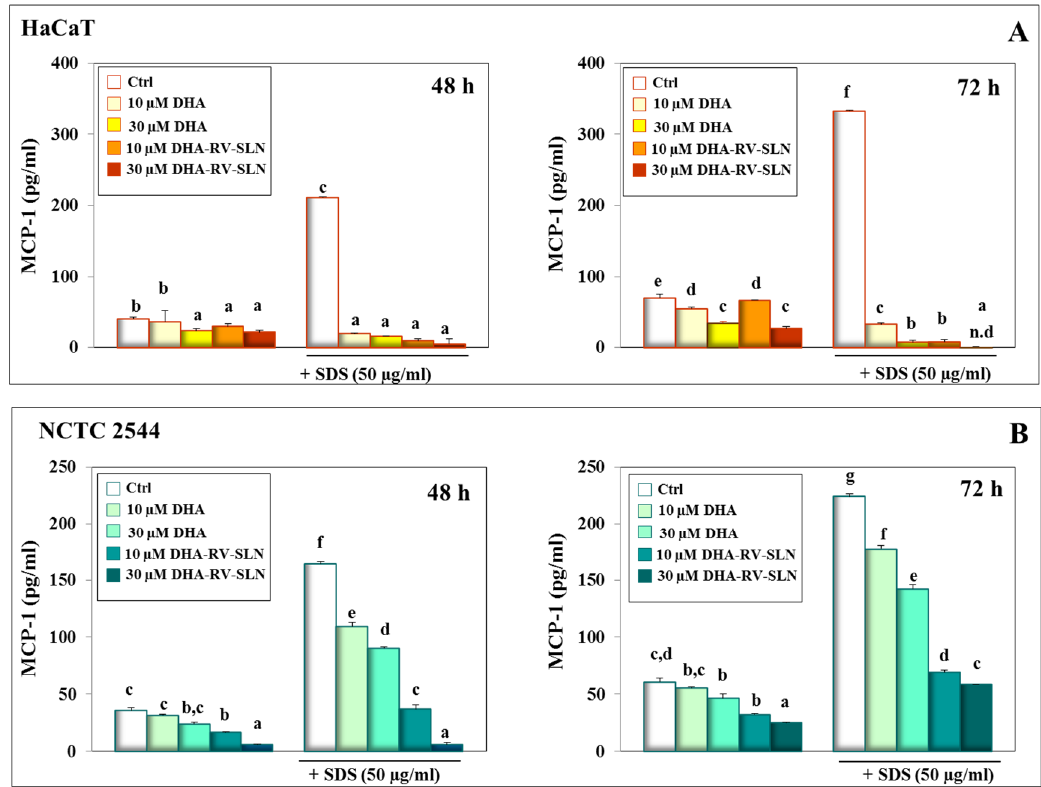
Figure 4. MCP-1 production in HaCaT and NCTC 2544 keratinocytes treated with SDS alone and in combination with DHA delivered or not through RV-SLNs. ( A ): HaCaT cells; ( B ): NCTC 2544 cells. The cells were treated with free DHA or DHA-RV-SLNs (10 or 30 µ M) in the absence or in the presence of 50 µ g / mL SDS for 48 (left panels) or 72 h (right panels). Data are the means ± SD of three di ff erent experiments. Values not sharing the same superscript letter are significantly di ff erent ( p < 0.05, one-way ANOVA followed by Tukey’s